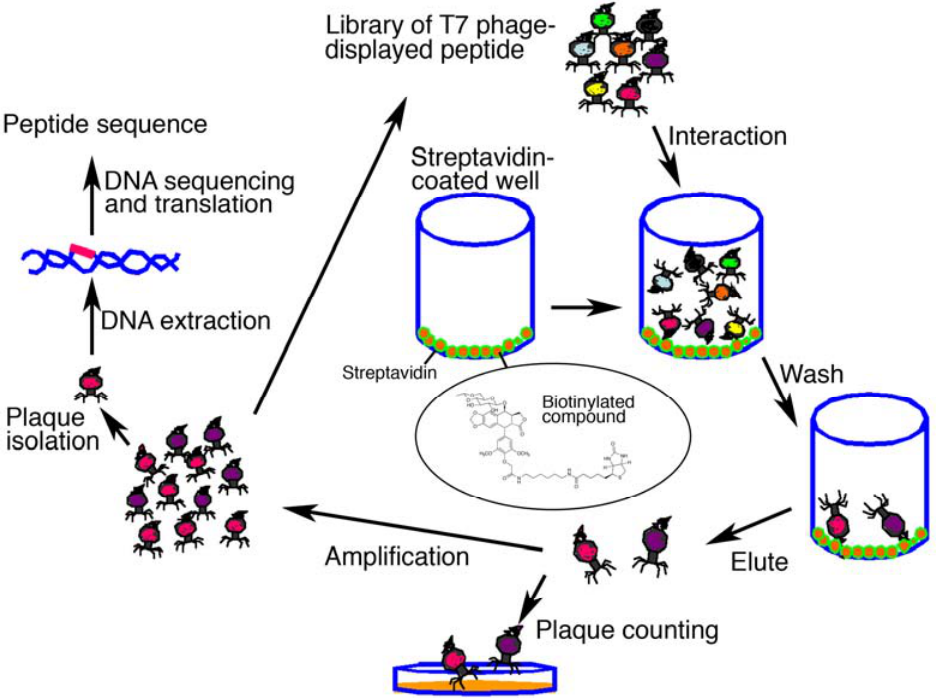
Figure 2. Schematic representation of affinity selection using phage display